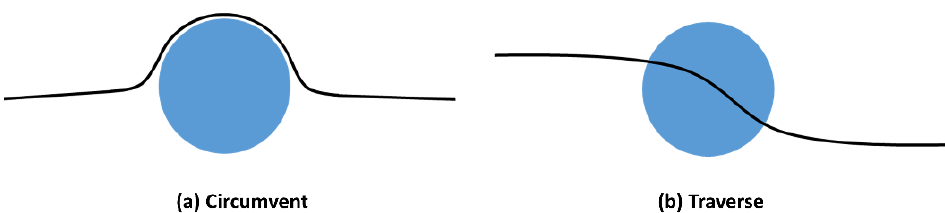
Figure 13. Schematic of possible crack paths when a crack interacts with a second-phase particle: ( a ) crack circumvents the particle or ( b ) crack traverses the particle. Recreated from [141].